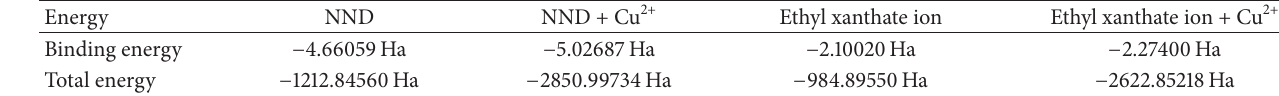
Table 7: Energy of NND and ethyl